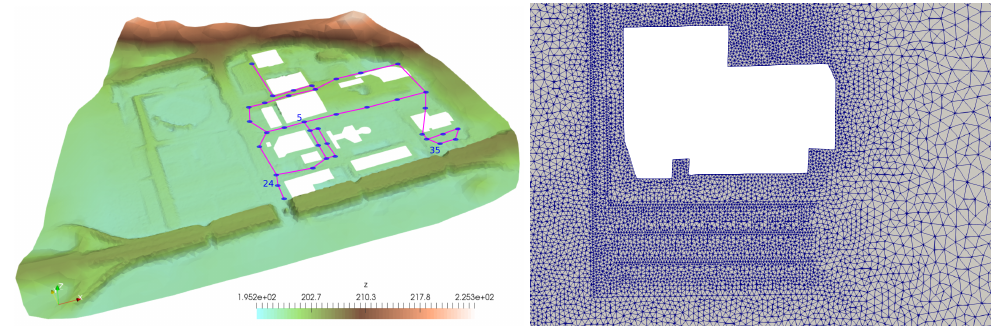
Figure 8. Case 2: 3D representation of the domain topography ( left ) and detail of the computational mesh showing the local refinement ( right